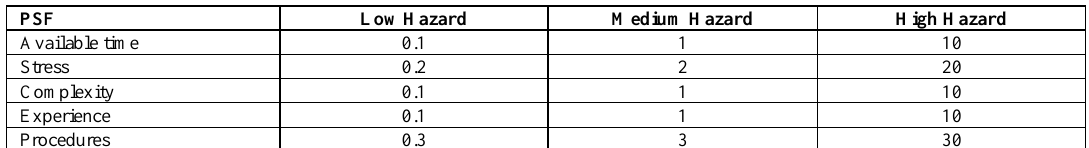
Table 6. PSFs values.